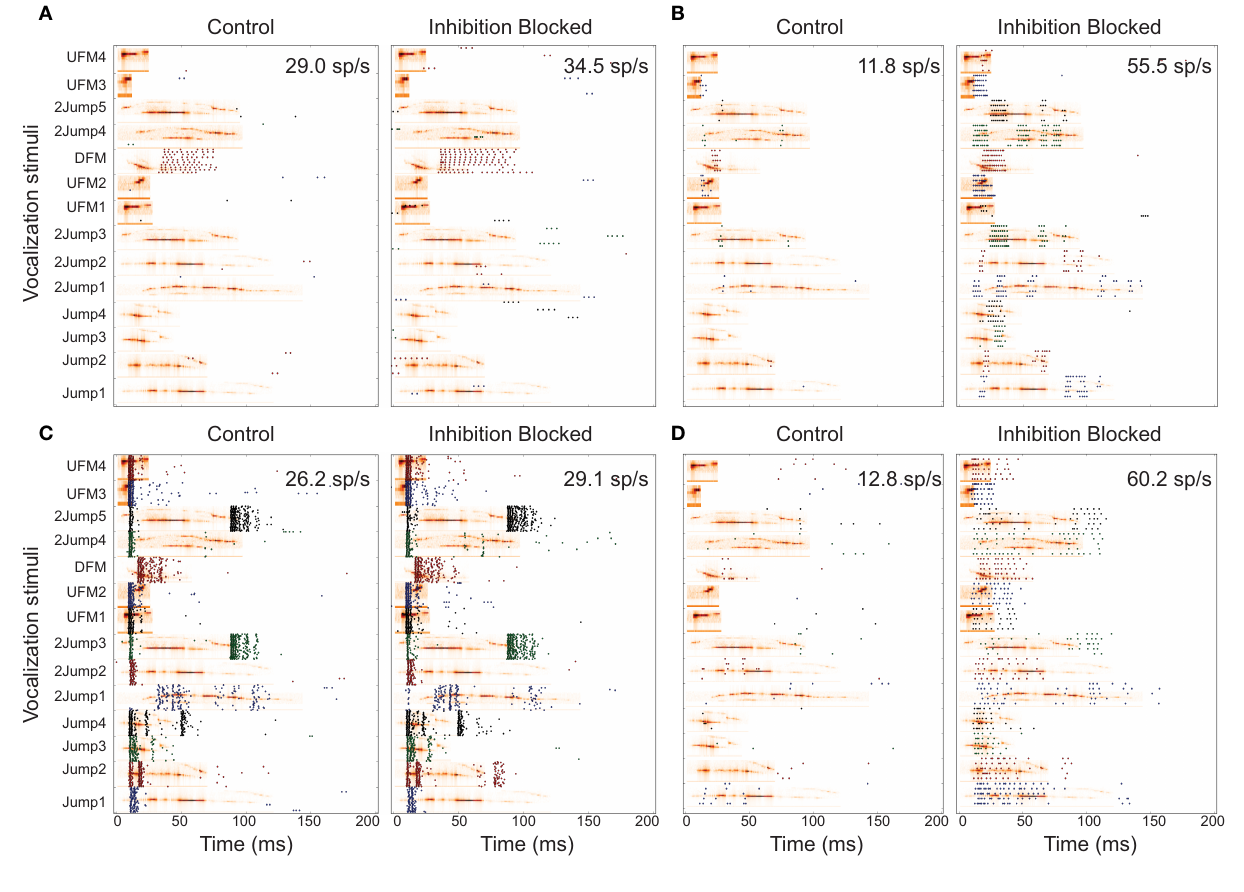
represented along the vertical axis and vocalization names are indicated. These vocalizations are types of commonly emitted syllables (Mahrt et al., 2013). The background images show the spectrograms of each vocalization. Each panel contains the average response spike rate, computed as total number of spikes/number of trials eliciting response/response window (158ms here). (A) selective neuron; (B) modified neuron; (C) patterned neuron; (D) inhibited